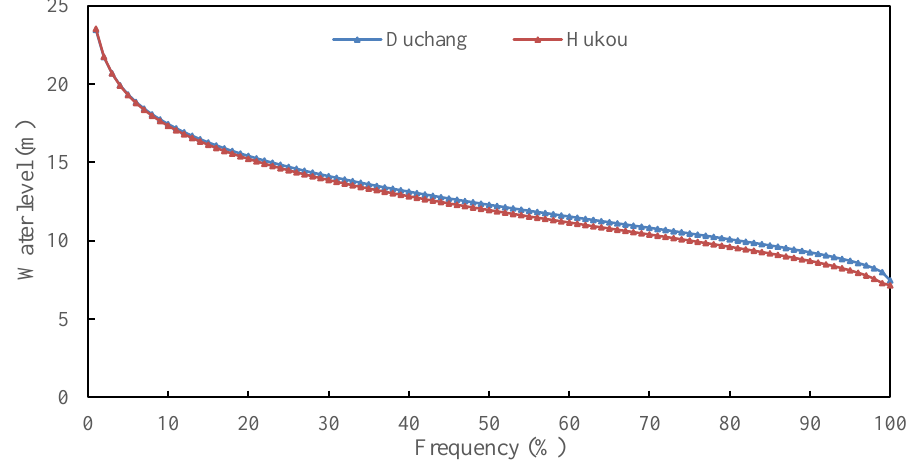
Figure 7. Comparison of water level frequency between the Hukou station and the Duchang station: the red line represents the water level frequency curve of the Hukou station, and the blue line represents the water level frequency curve of the Duchang station.